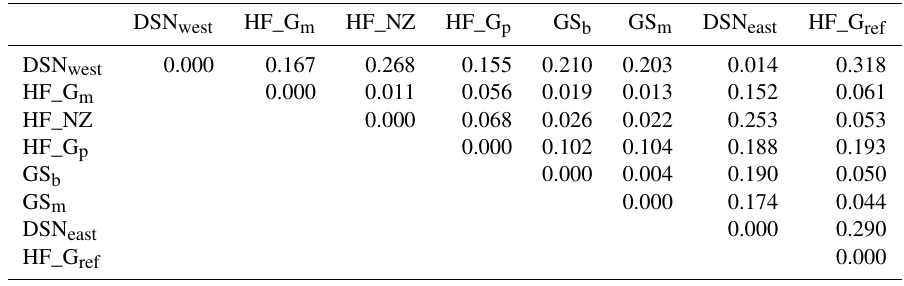
Table 5. Matrix of Nei’s standard genetic distance ( D s ) (Nei, 1972) obtained from the haplotype